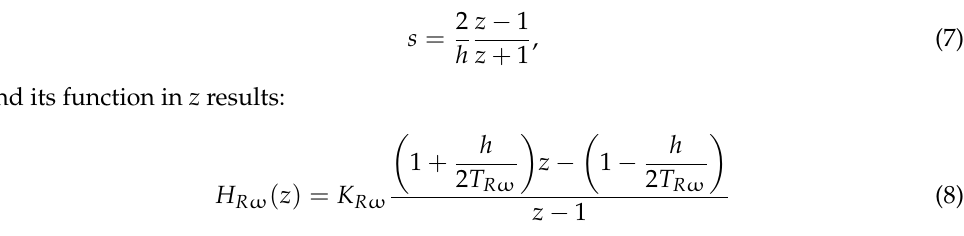
Figure 2. Block diagram of the linear control system.